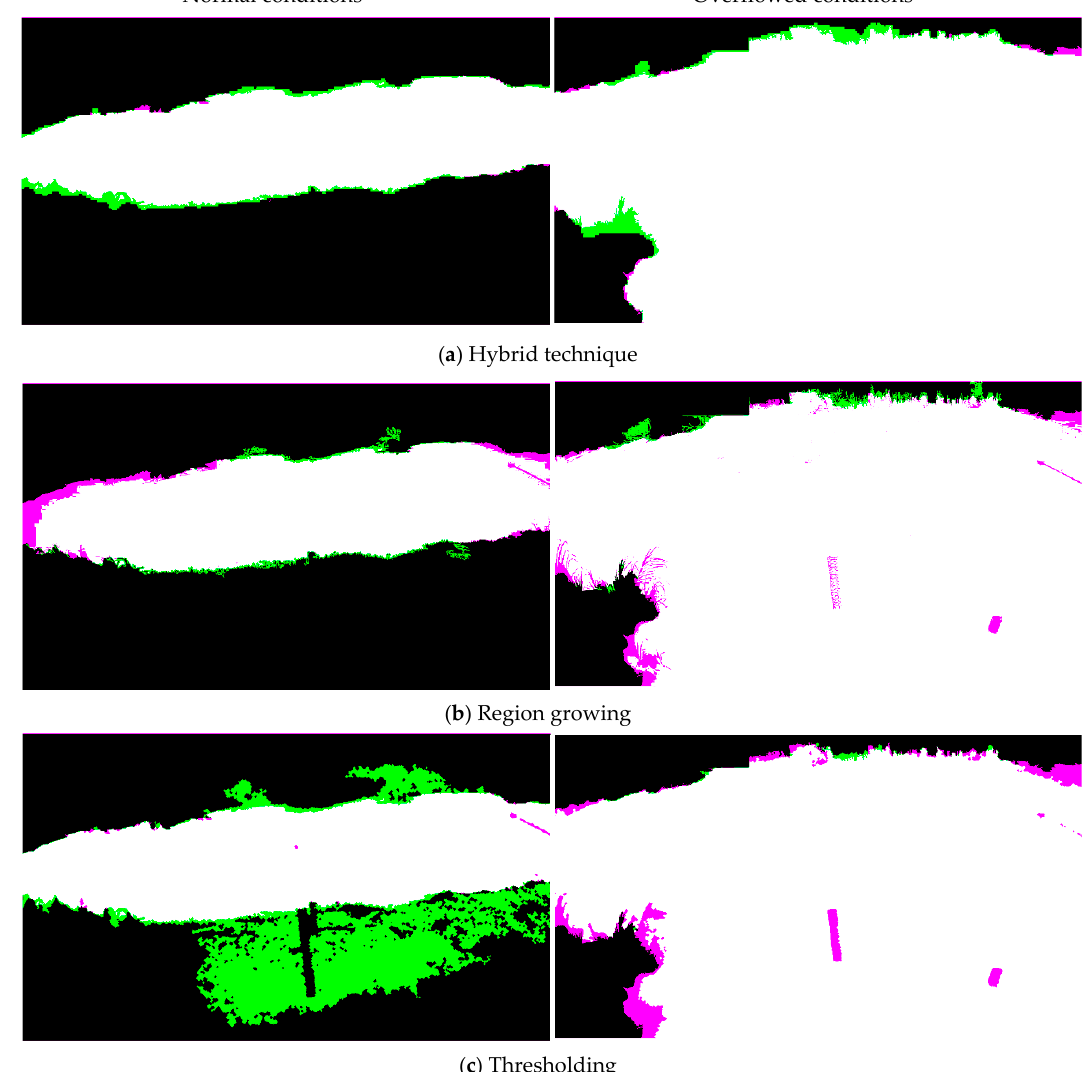
Figure 5. The comparisons between the segmentation results and the ground truth images when using ( a ) hybrid technique, ( b ) region growing, and ( c ) thresholding.